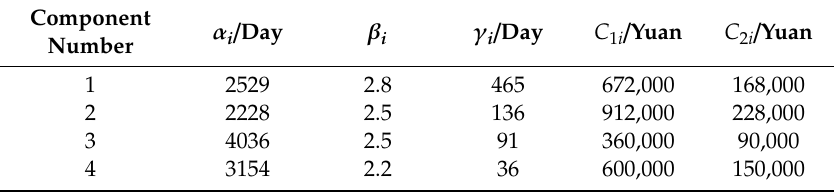
Table 9. Weibull distribution parameters and maintenance costs of critical components.